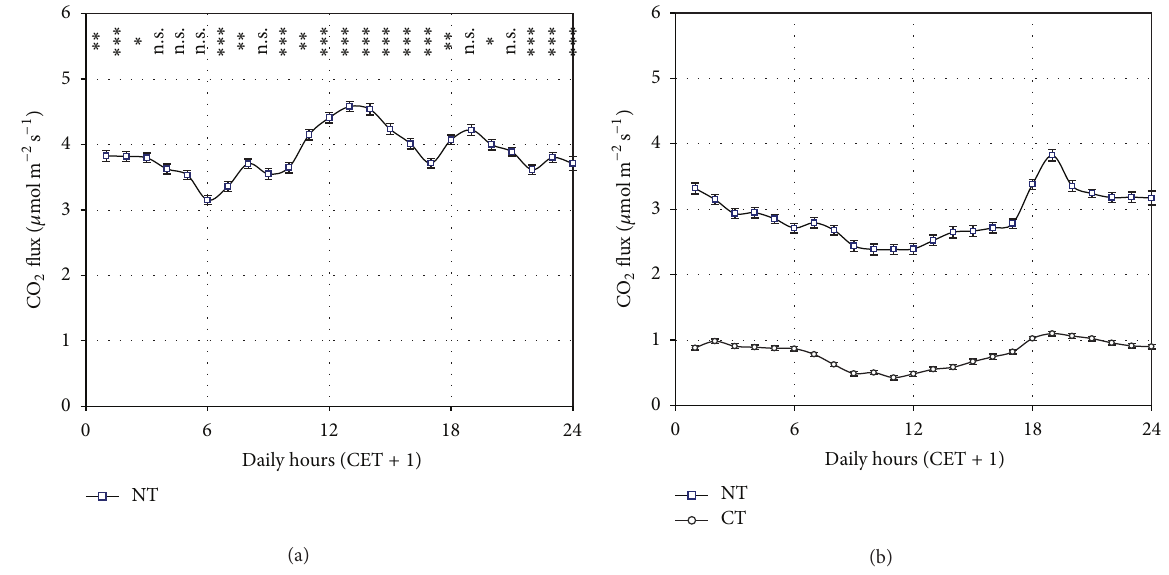
Figure 4: Average daily course of CO 2 fluxes for the July-August (a) and September-October (b) periods. Each point represents the average of the fluxes measured by all the chambers of the SASSFLUX system at each site for all the days of each two-month periods during the hour indicated in the 𝑥 -axis. Vertical bars indicate the standard errors of the average value. CET + 1 indicate the “legal” time of the Central Europe Time zone. The statistical significance of the differences between the flux daily courses of the two periods in the NT site is reported (for each hour) at the top of the graph (a) ( ∗∗∗ 𝑃 < 0.001 ; ∗∗ 𝑃 < 0.01 ; ∗ 𝑃 < 0.05 , and n.s. 𝑃 > 0.05 ). Differences between the flux daily courses of the NT and CT sites were always statistically significant ( ∗∗∗ 𝑃 < 0.001 ) and thus it was not indicated in the graph (b). The maize harvest occurred in both fields between the two periods